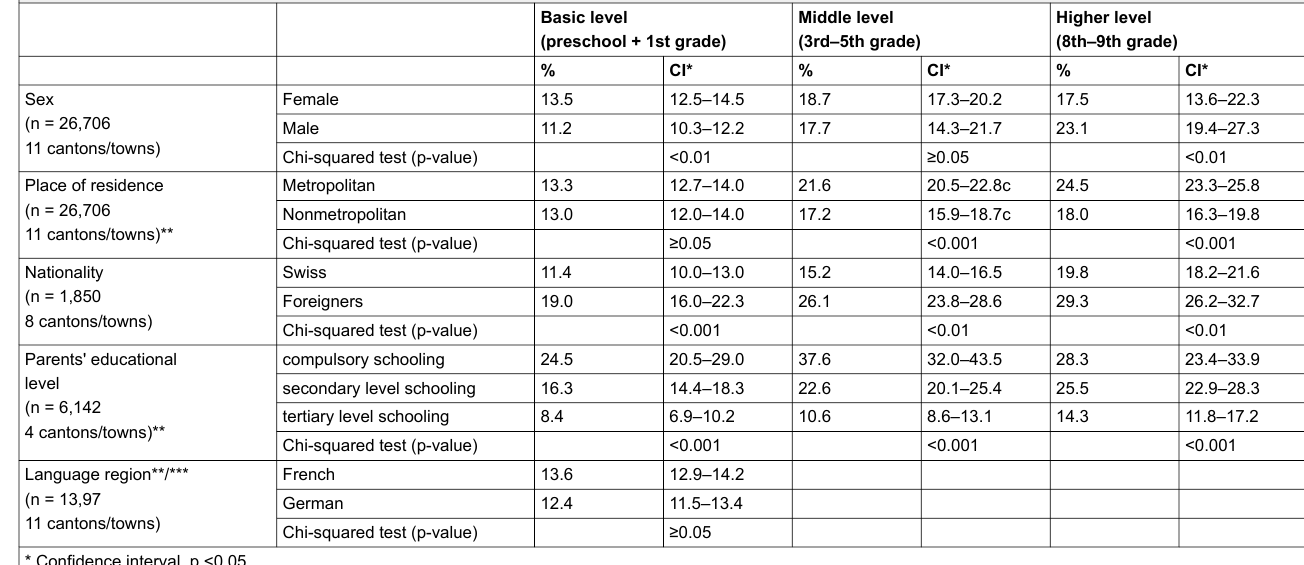
Table 5: Rate of excess weight (overweight plus obesity) of children and adolescents by sex, place of residence, nationality and parents' educational